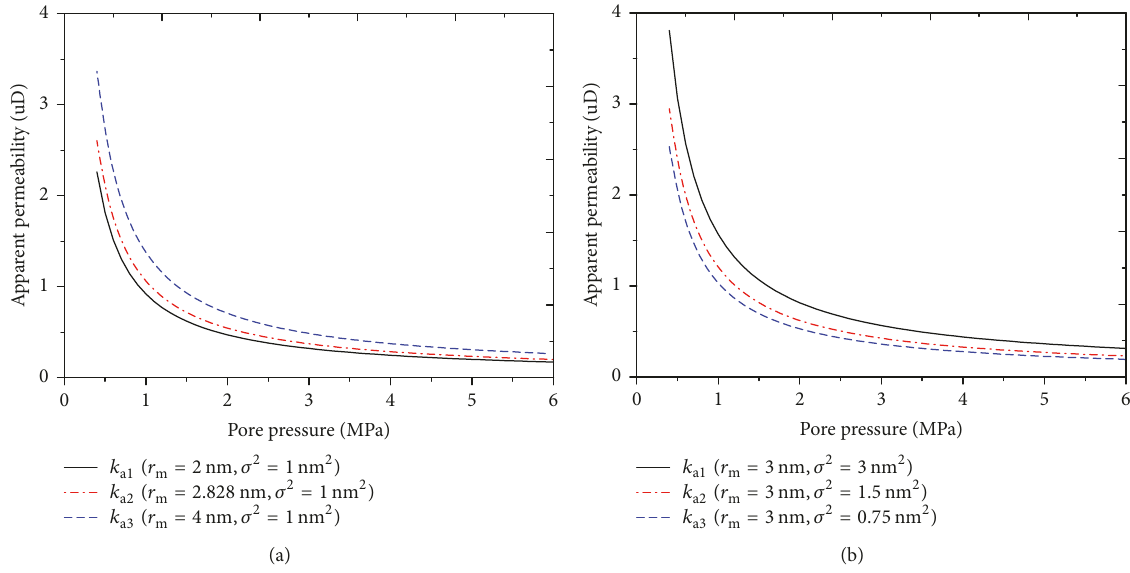
Figure 5: Apparent permeability as a function of pore pressure. The lines are calculated from (10). The parameter set is presented in Table 2. (a) The effect of 𝑟 on the apparent permeability. (b) The effect of 𝜎 2 on the apparent permeability. m